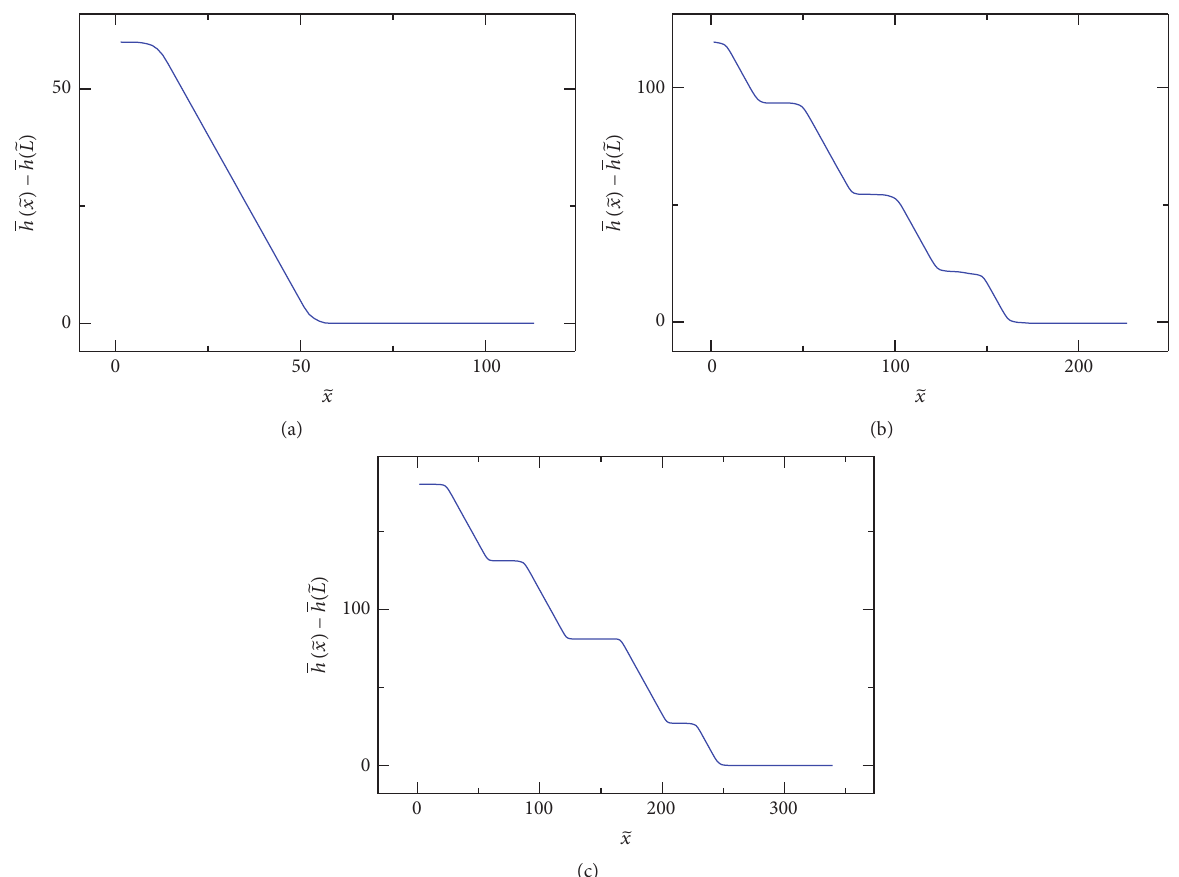
Figure 10: Size effect on the averaged height profiles ℎ(̃𝑥) of the vicinal surface. (a) Size: 80√2 × 80√2 , 𝑁 step = 60 . (b) Size: 160√2 × 160√2 , 𝑁 = 120 . (c) Size: 240√2 × 240√2 , 𝑁 step